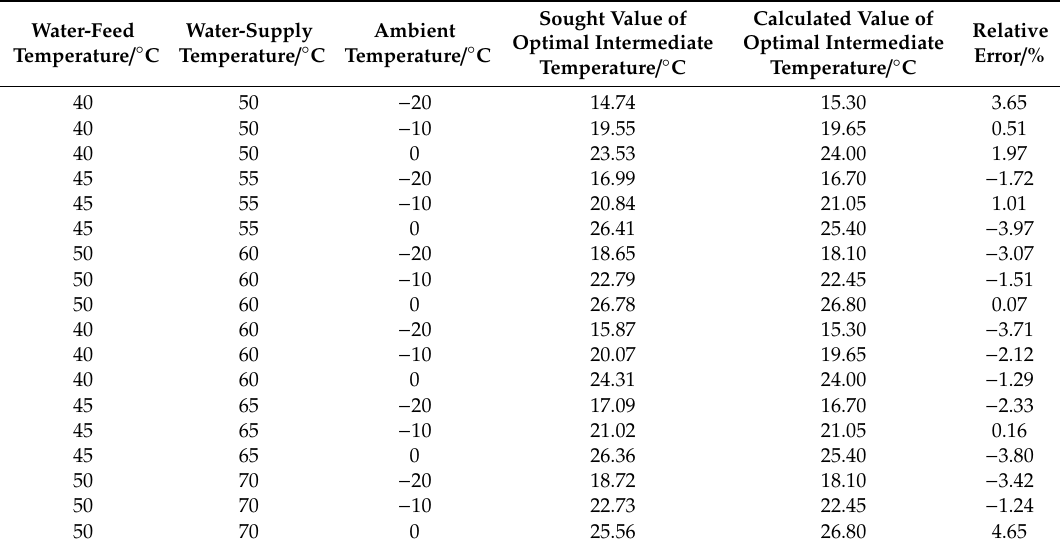
Table 3. The prediction errors between the sought optimal intermediate temperatures and the predictive